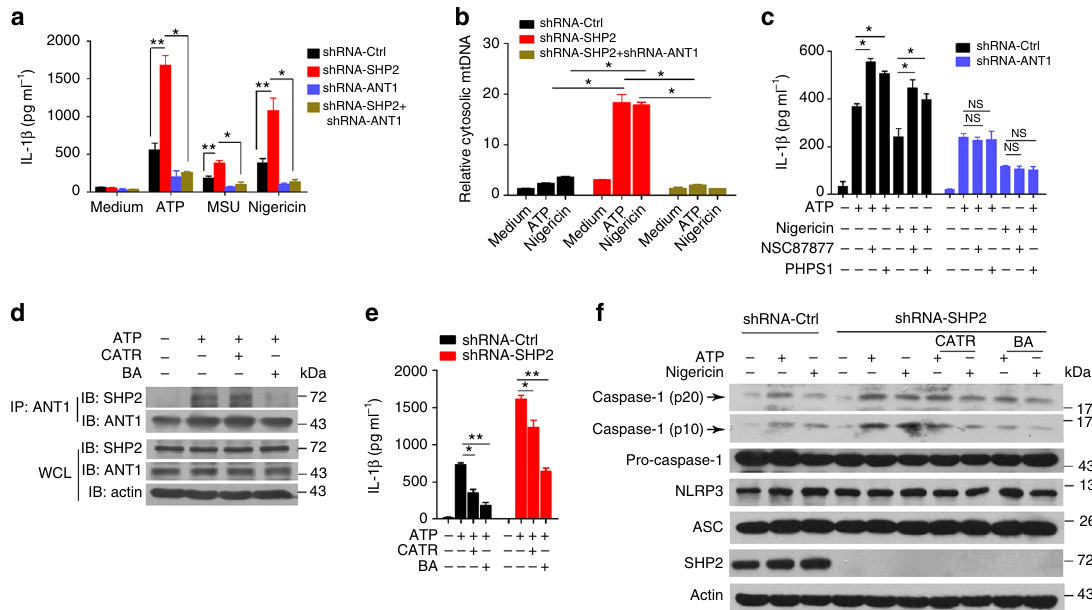
Fig. 8 SHP2 inhibits NLRP3 in fl ammasome activation in an ANT1-dependent manner. a , b SHP2 knockdown, ANT1 knockdown and SHP2-ANT1 double knockdown THP-1-derived macrophages were primed with 100 ng ml − 1 LPS for 3 h, followed by ATP (5 mM, 1 h), MSU (500 µ g ml − 1 , 2 h), or Nigericin (10 µ M, 2 h) stimulation, respectively. a ELISA of IL-1 β in the supernatant. b Quantitative real-time PCR analysis of mtDNA. c ELISA of IL-1 β in the culture supernatant from ANT1 knockdown THP-1-derived macrophages and left untreated or treated with NSC87877 (10 μ M) or PHPS1 (10 μ M) for 1 h, followed by ATP or Nigericin stimulation. d – f LPS-primed SHP2 knockdown THP-1-derived macrophages were treated with CATR (5 mM) or BA (50 µ M) for 1 h, followed by ATP or Nigericin stimulation. d Immunoblot analysis of Co-IP from THP-1-derived macrophages treated with CATR or BA. e ELISA of IL-1 β in the culture supernatant. f Immunoblot analysis of cell lysates from THP-1-derived macrophages treated with CATR or BA. * P < 0.05, ** P < 0.01, one-way ANOVA for multiple comparisons, NS represents no signi fi cance. Data are representative of three independent experiments (mean and SEM of three independent samples in a – c , e